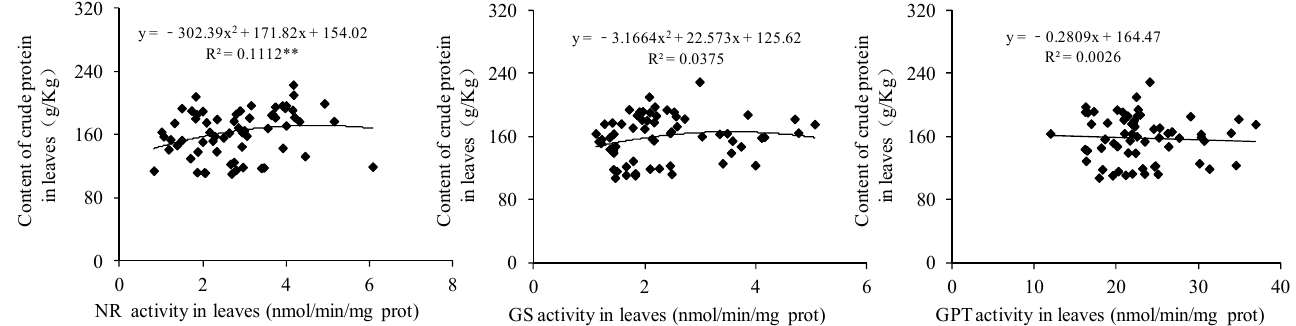
Figure 11. Relationships between crude protein content and key enzyme activity in leaves. Note: “**” indicate a significant correlation at the 0.01 probability level. The dots represent the measured values, and the lines represent the correlation trend in the figure.